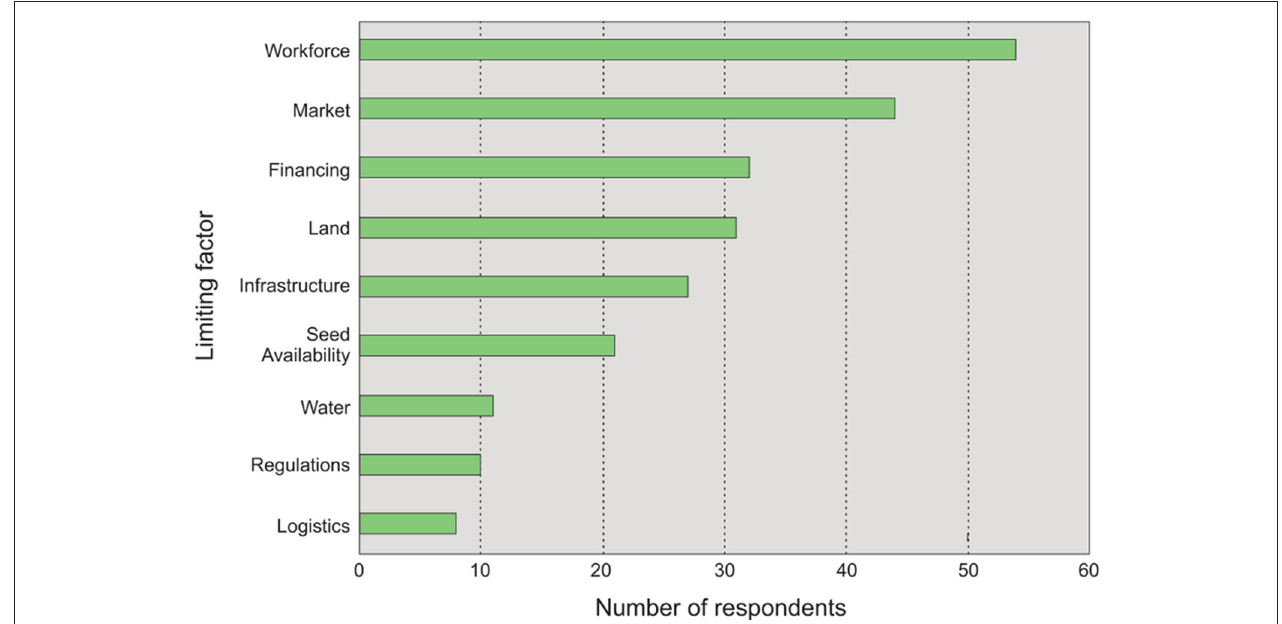
Table 1 . Survey respondents reported mechanical and